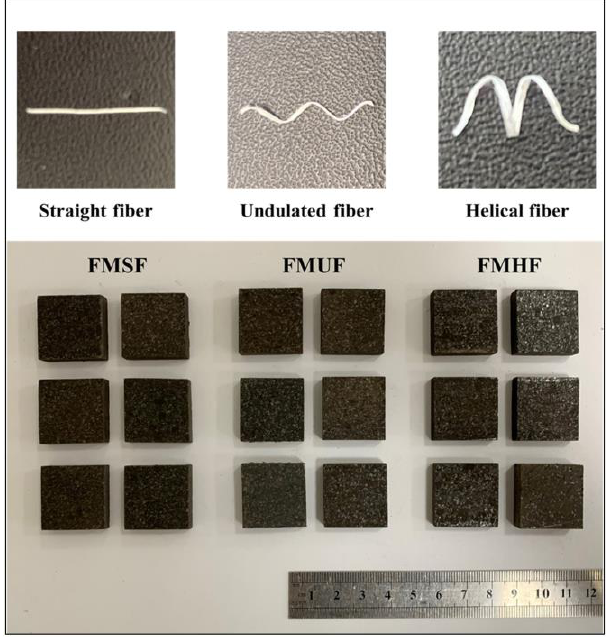
Figure 2. The friction composite samples after fabrication.